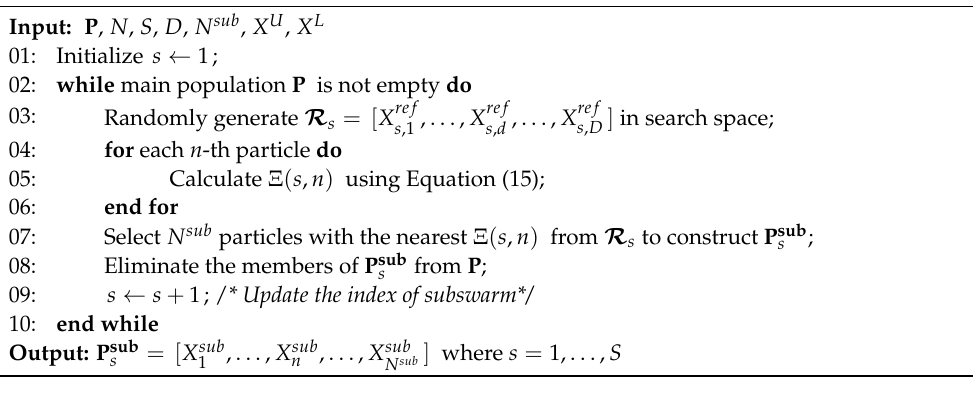
Algorithm 2. Pseudocode of reference-point-based population division scheme used to generate the multiswarm for the primary learning phase of MSPSOTLP